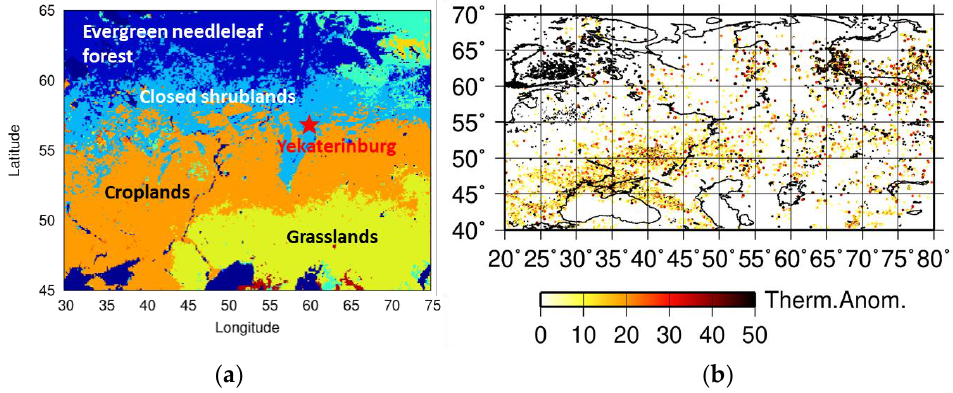
Figure 7. Land type map of the target area and location of the Yekaterinburg observation site ( a ); averaged thermal anomaly (relative units) detected by MODIS during June – August in 2013 ( b ).